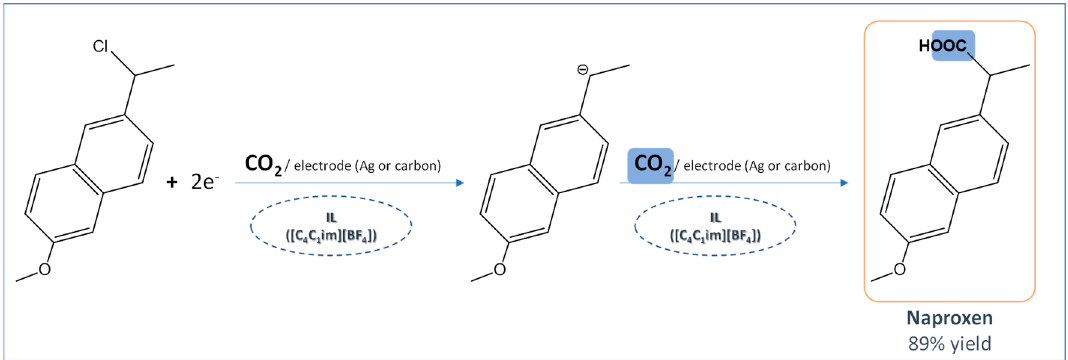
Figure 7. Schematic representation of naproxen’s electrosynthesis under CO2 atmosphere proposed in [60].